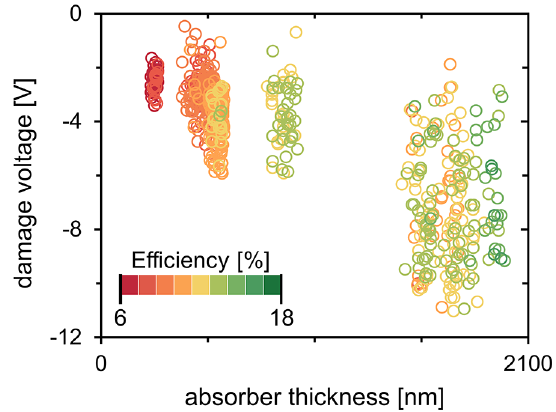
Fig. 2. Damage voltage for dark reverse bias as function of absorber thickness. The initial ef fi ciency of the individual solar cells is represented with a color scale.